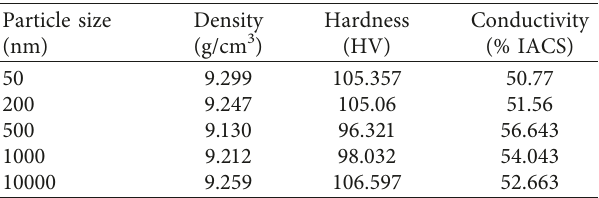
Table 2: The physical properties of AgSnO material.